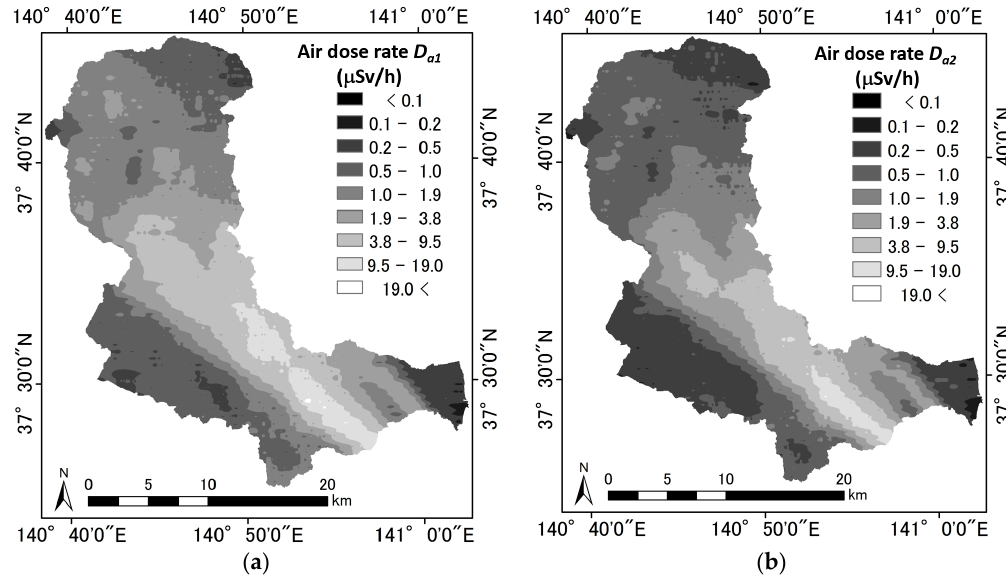
Figure 4. Maps of the air dose rate: ( a ) before snowfall; and ( b ) after snowfall.